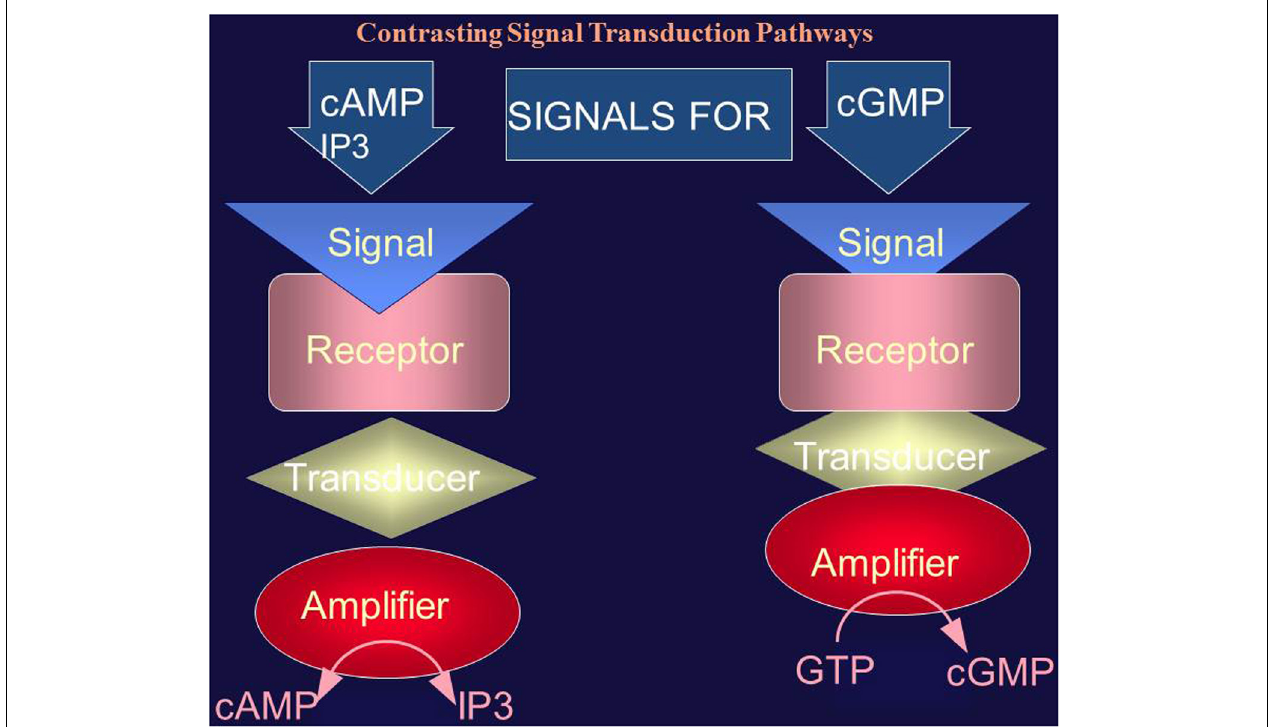
FIGURE 2 | Comparison of the cyclic AMP (and IP3) and cyclic GMP signaling systems. The cyclic AMP (and IP3) signaling system consists of three separate components: hormone receptor, transducer (G protein) and amplifier (adenylate cyclase). The cyclic GMP signaling system consists of a single protein. The hormonal signal is recognized by the